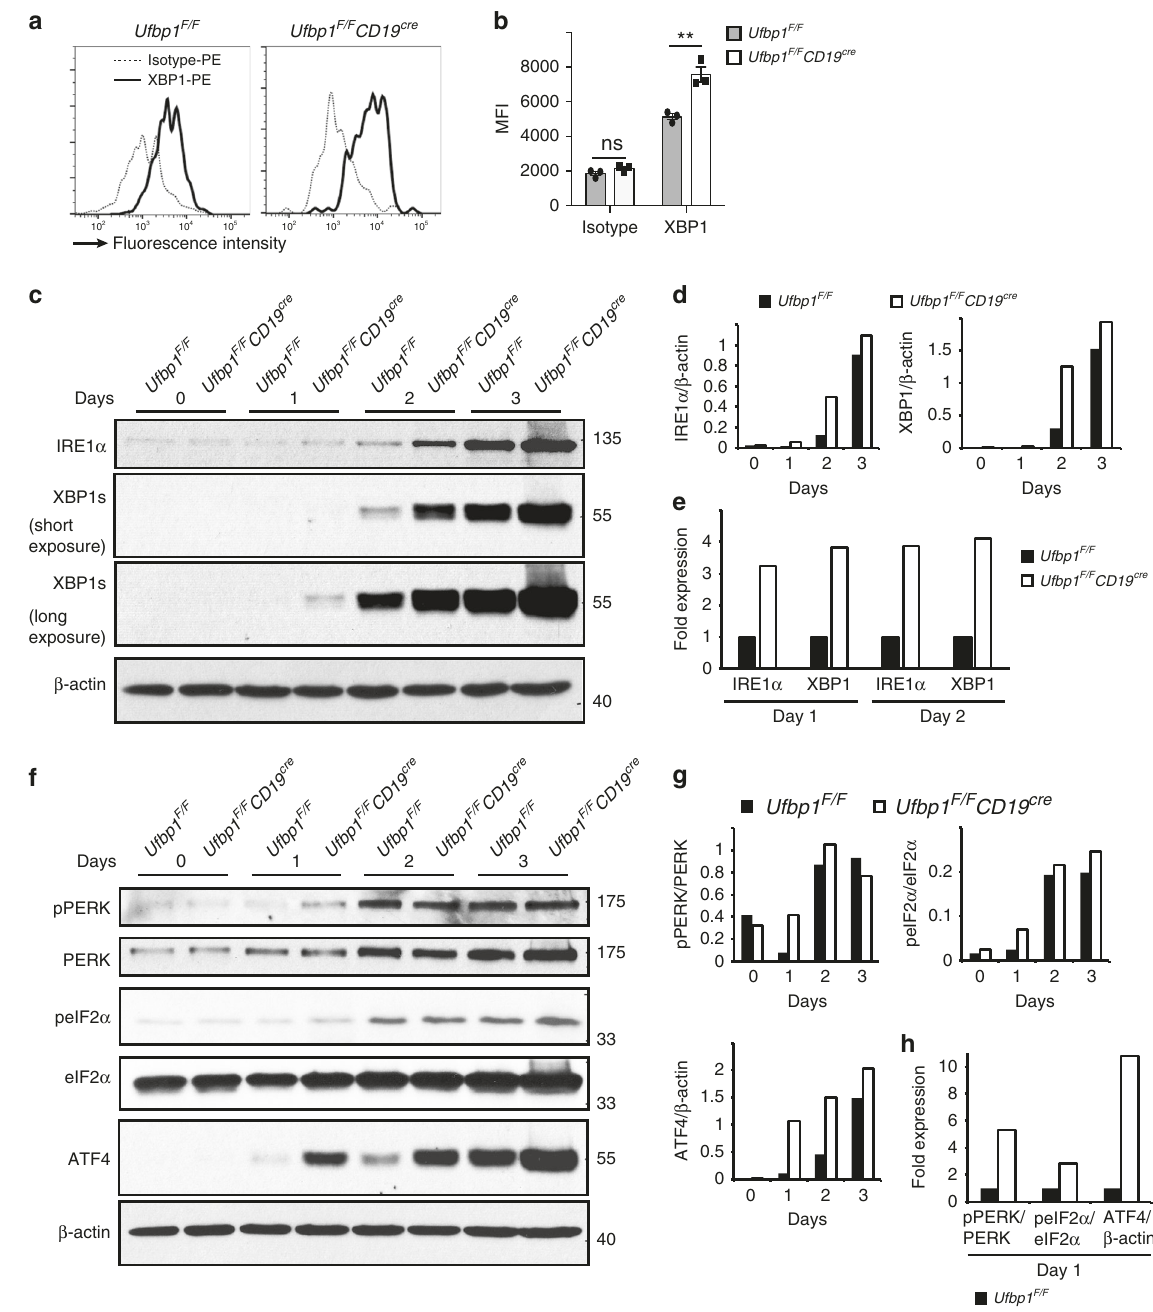
Fig. 5 An essential role of Ufbp1 in regulation of unfolded protein response signaling. a Flow cytometric detection of spliced XBP1 (XBP1s) expression in bone marrow plasma cells of mice of indicted genotype. Dotted and solid lines represent the staining for control isotype and anti-XBP1s antibodies respectively. b Quanti fi cation of XBP1s expression in a ( n = 3 mice/genotype). c , f Naive B cells from Ufbp1 F/F and Ufbp1 F/F CD19 cre mice were stimulated with lipopolysaccharide. At indicated time points, cells were harvested and total cell lysates were immunoblotted with antibodies against indicated molecules. d , g Quanti fi cation of expression of indicated molecules normalized against β -actin in c and f respectively. e , h Data on indicated days from d and g were replotted. Expression value of indicated molecules in cells from Ufbp1 F/F mice on indicated time point was taken as 1. Error bars represent mean ± standard error. ** P < 0.01. ns nonsigni fi cant. Unpaired Student ’ s two-tailed t -test was used. A representative of at least two experiments is de fi cient B cells, which was signi fi cantly higher than in cultures of Ufbp1-de fi cient B cells (Fig. 6e, f, Supplementary Fig. 6d). Deletion of PERK rescued the defective development of Ufbp1-de fi cient B cells into plasmablasts, because frequencies of BLIMP1 + CD138 high and IRF4 + Pax5 − cells in cultures of B cells lacking both Ufbp1 and PERK were signi fi cantly higher than in cultures of B cells lacking WT and PERK-